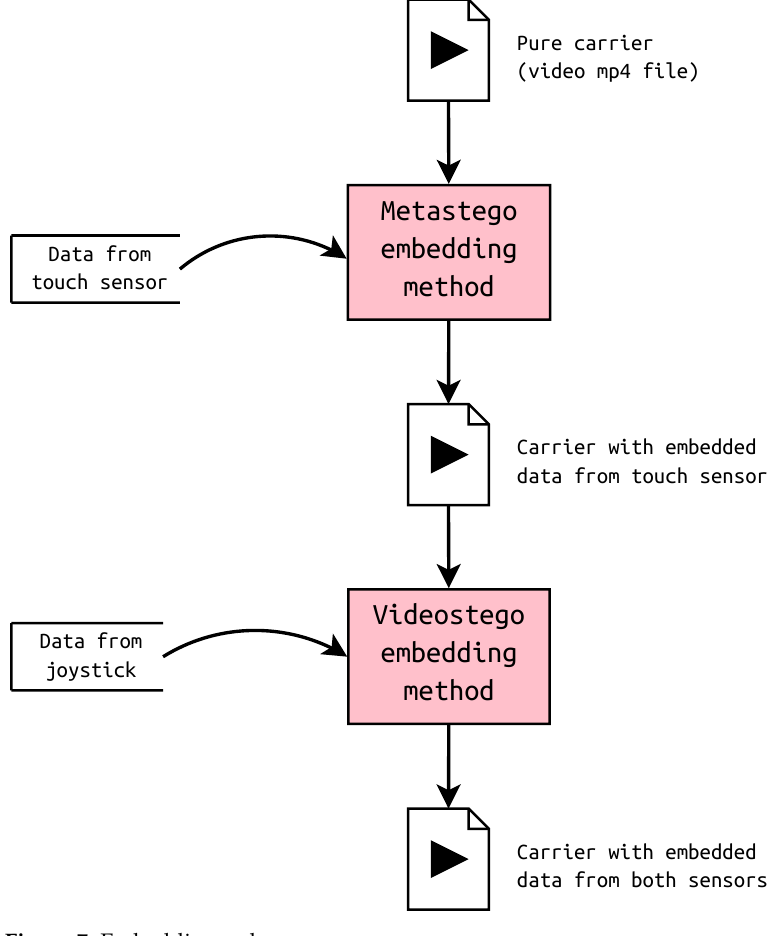
Figure 7. Embedding